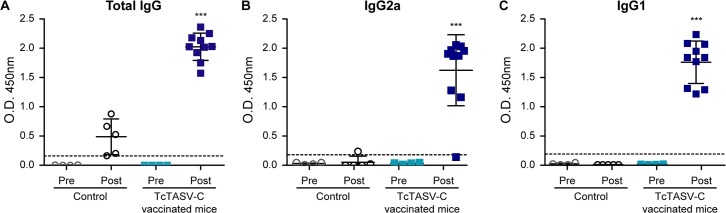
Anti-TcTASV-C antibody response in mice after vaccination.Serum samples were obtained before the first (Pre) and 15 days after the last dose (Post) of immunization with TcTASV-C or Control schemes. (A) Total IgG, (B) IgG2a and (C) IgG1 responses against rTcTASV-CGST were determined by ELISA. Each dot represents one individual animal. Absorbance against GST was subtracted. Dotted line indicates the cut-off (***p< 0.005 vs control group, one-way ANOVA).